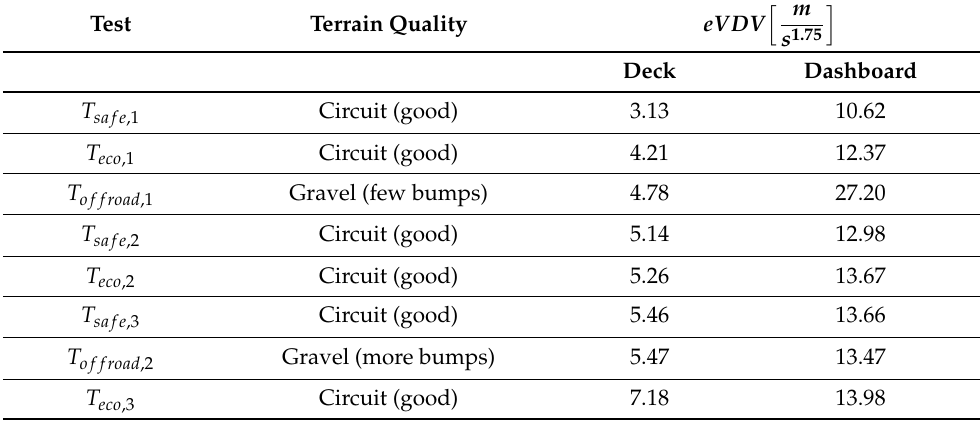
(cid:104) m (cid:105) s 1.75 Deck Dashboard